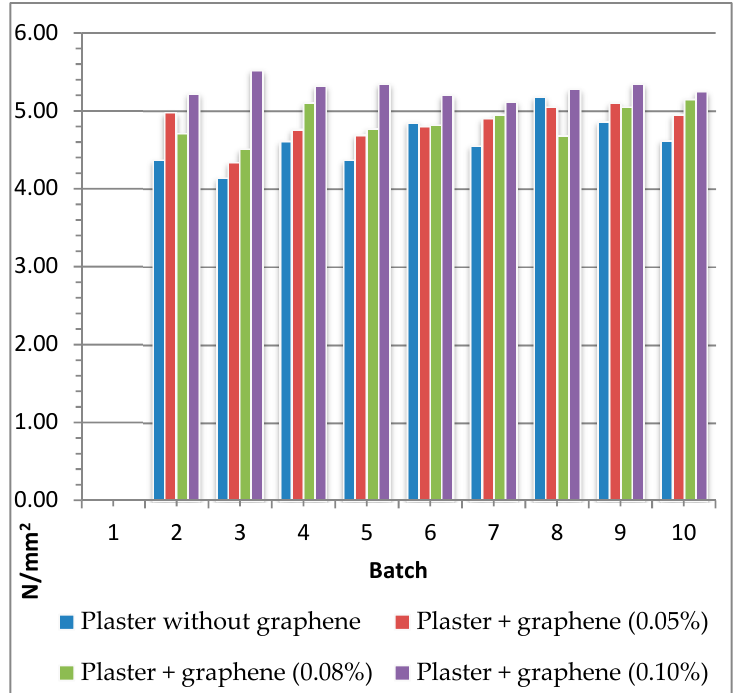
Figure 3. Bar graph of flexural strength test results of gypsum mortar with graphene added in the proportions of 0.05%, 0.08%, and 0.10%.